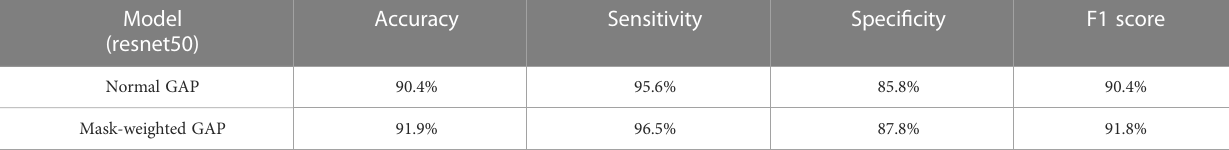
TABLE 2 The classi fi cation results of the proposed Mask-weighted GAP and the comparison with normal GAP based on resnet50. Model (resnet50)